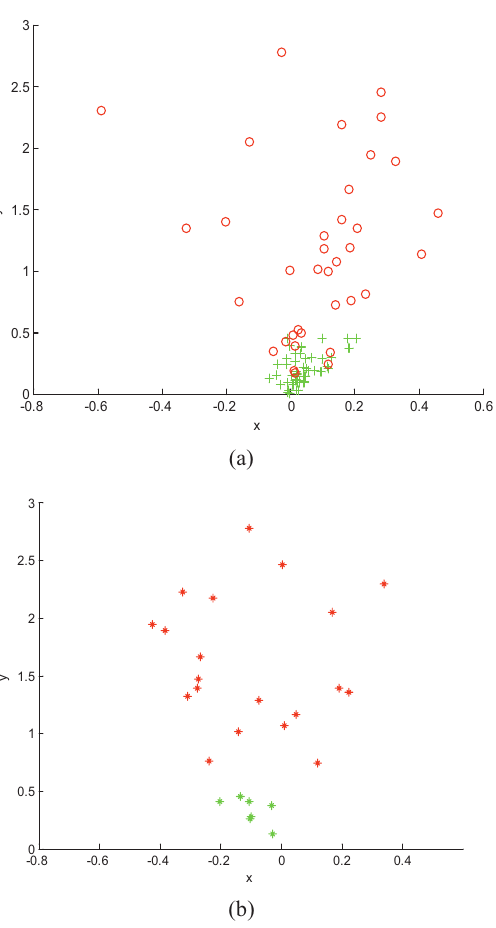
Fig. 5. Data distribution of first 90 modules